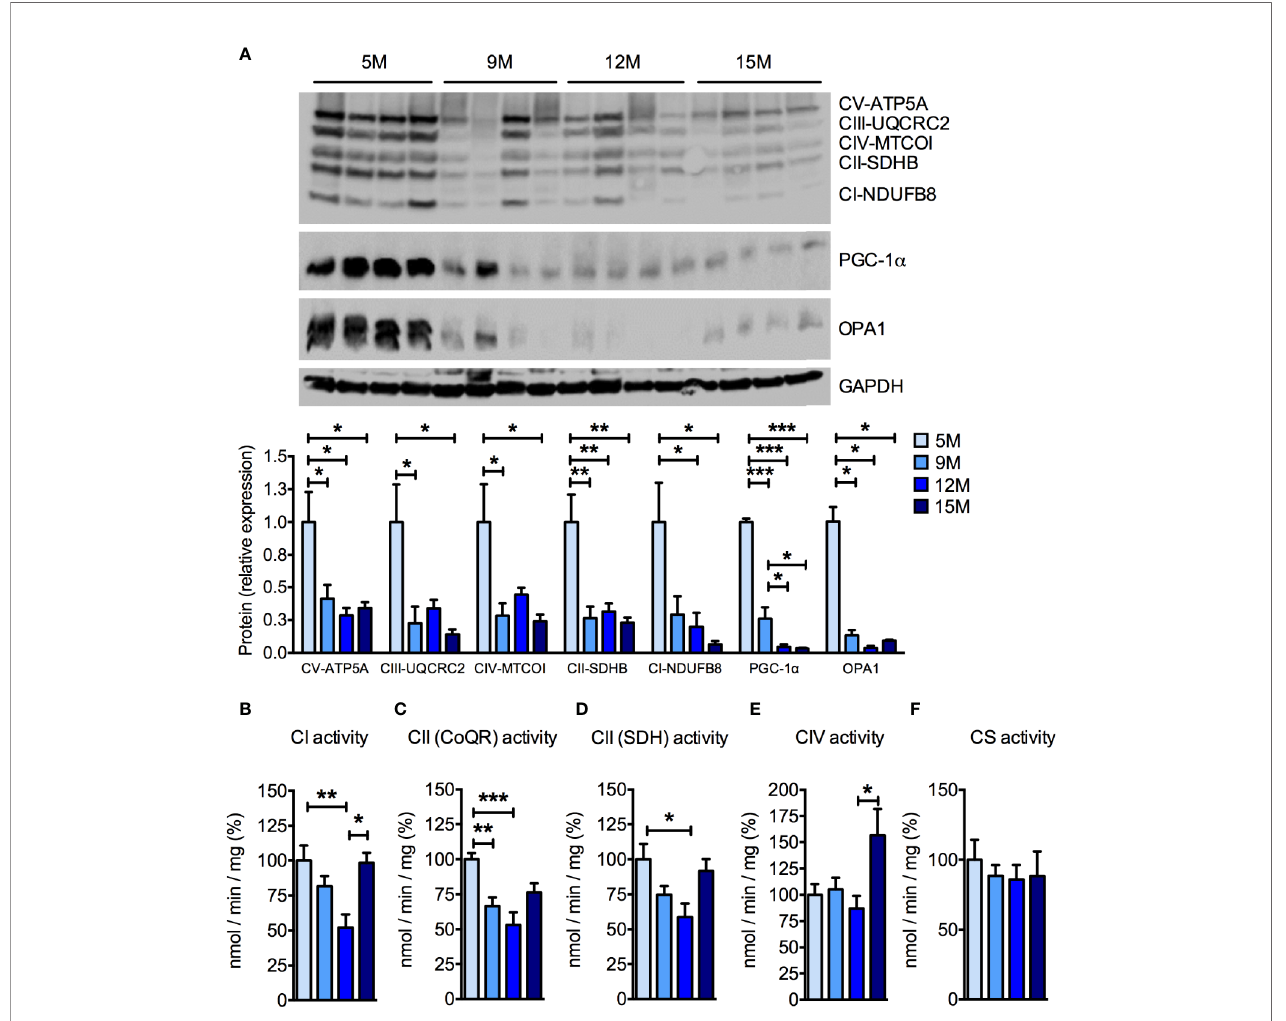
FIGURE 2 | Age-dependent mitochondrial dysfunction in the skeletal muscle of SAMP8 mice. (A) Western blot analysis of the mitochondrial respiratory chain (MRC) subunits ATP5A (complex V), UQCRC2 (complex III), MTCOI (complex IV), SDHB (complex II), and NDUFB8 (complex I) at different ages. The quanti fi cation of each signal was normalized to the amount of GAPDH and represented below the images. (B – F) Enzymatic activities of MRC complex I (CI), succinate-coenzyme Q reductase (CoQR) and succinate dehydrogenase (SDH) activities of complex II (CII), complex IV (CIV), and citrate synthase activity were measured at different ages. All color codes as in (A) . Statistical analysis was performed with one-way ANOVA and Tukey ’ s multiple comparison test. Error bars represent SEM; n=4 mice/group (A) and n=6 mice/group (B – F) ; *p < 0.05, **p < 0.01, ***p <